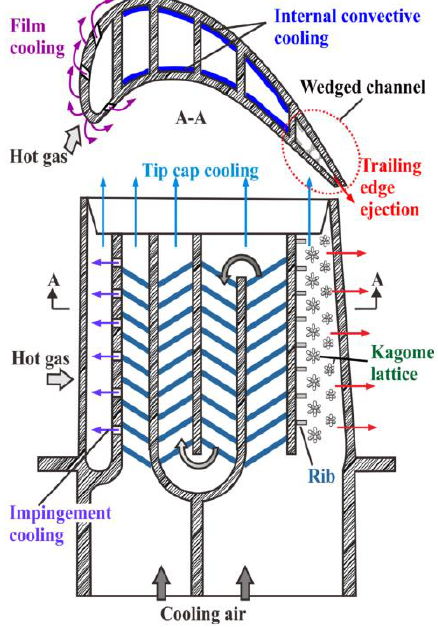
Figure 5. Cooling channel of a gas turbine blade trailing edge mounted with Kagome lattice structures. Reprinted/adapted with permission from Ref. [69]. 2019, Elsevier Ltd.